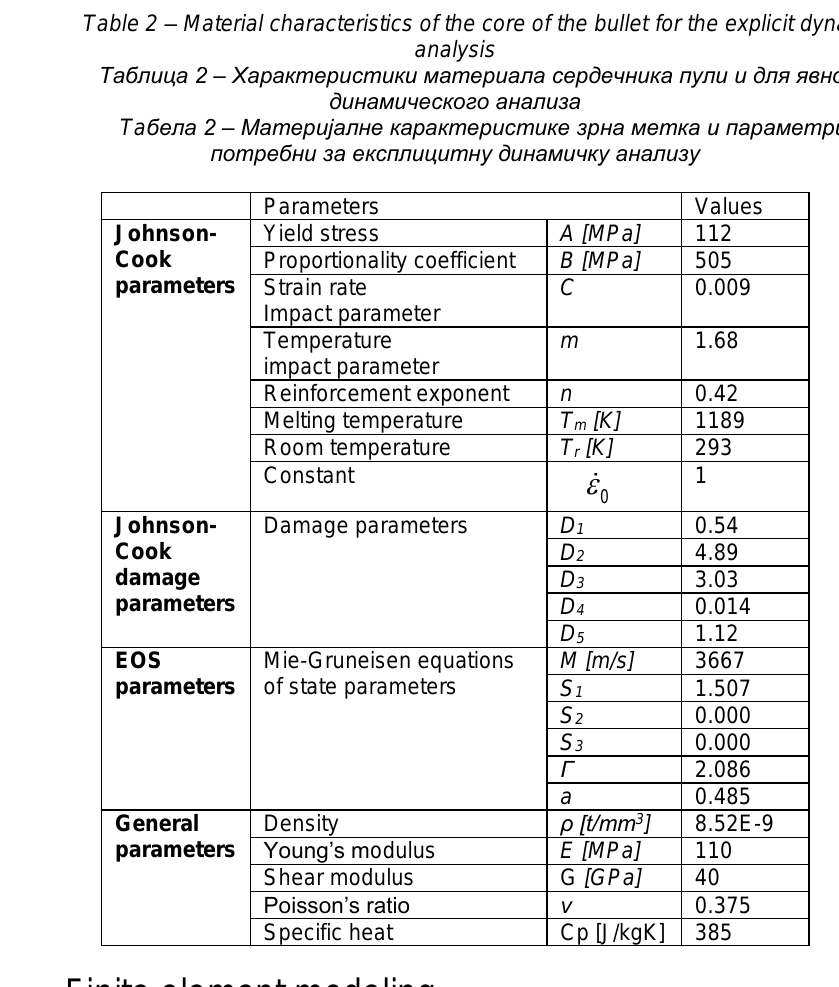
Table 2 – Material characteristics of the core of the bullet for the explicit dynamic